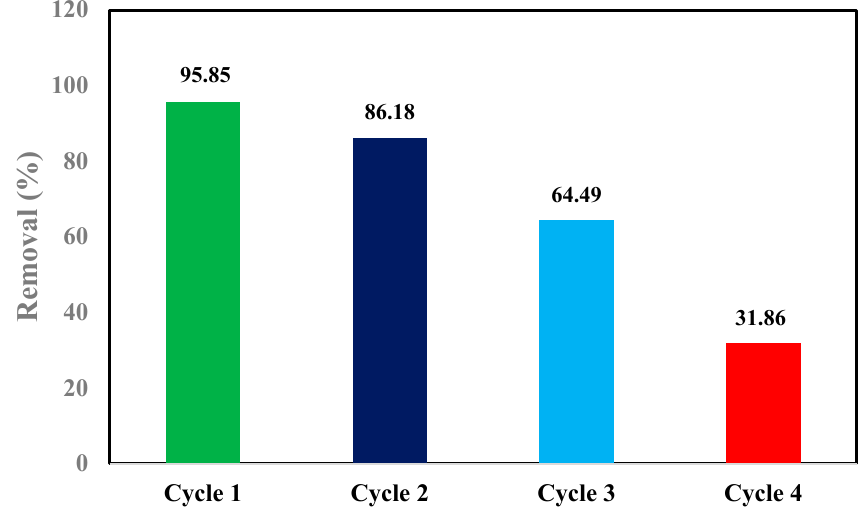
Figure 11. Reusability of MgO-IBC for the removal of arsenate in four adsorption/desorption cycles.